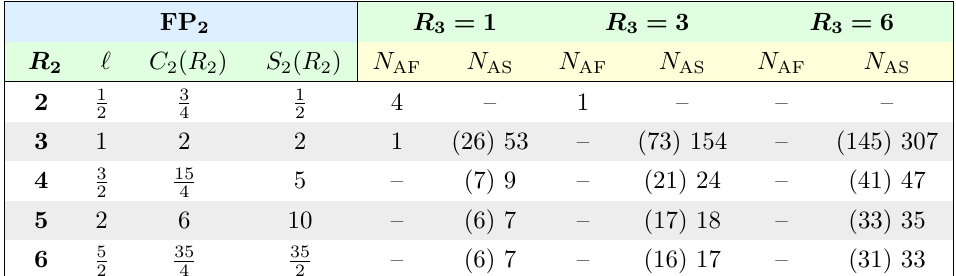
Table 5 . Asymptotic freedom versus asymptotic safety at the partially interacting (cid:12)xed point FP 2 : shown are the maximal numbers of BSM fermion (cid:13)avors N F < N AF compatible with asymptotic freedom, and the smallest number N F (cid:21) N AS required for a weakly-coupled asymptotically safe (cid:12)xed point, both in dependence on the fermion representations R 2 and R 3 under SU(2) L and SU(3) C , respectively. Values for N AS in brackets relate to the absolute lower bound, those without brackets to settings with 0 < (cid:11) (cid:3) ; (cid:11) (cid:3) < 1. Also indicated are the weight ‘ , the quadratic Casimir, y 2 and the Dynkin index under SU(2) L